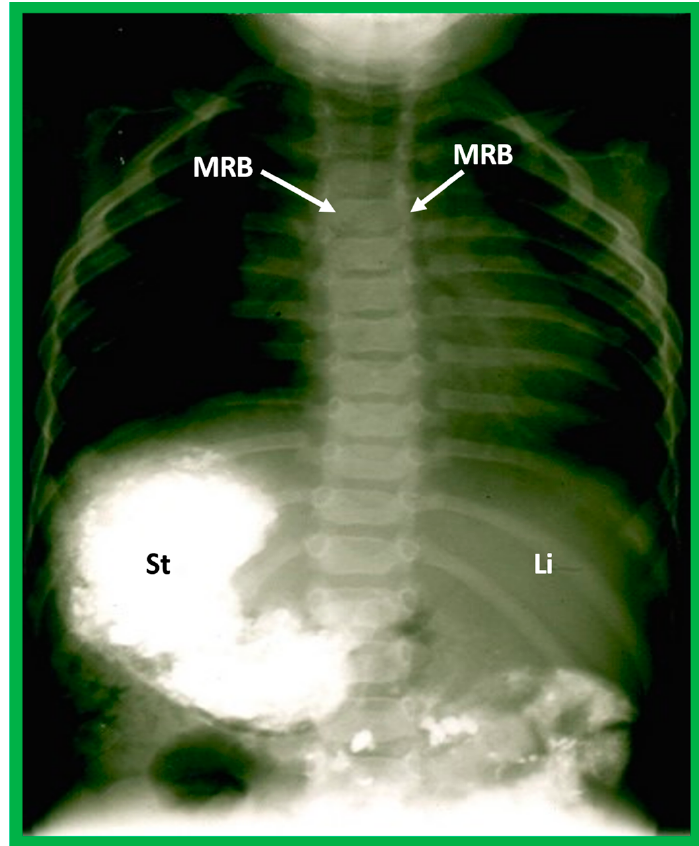
Figure 21. Barium study showing barium in the stomach (St) on the right side while the liver (Li) is seen on the left, indicating situs inversus. The heart is on the left side, indicating isolated levocardia. Tracheobronchial tree pattern shows morphologic right bronchus (MRB) on both sides, indicative of dextro-isomerism.